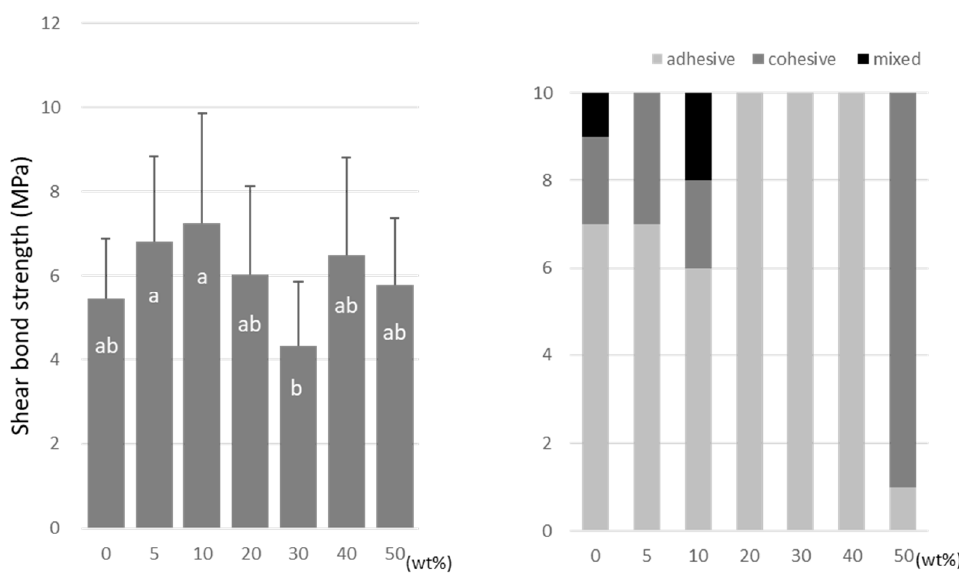
Figure 6. Shear bond strength ( left ) between CAD/CAM PMMA disk and TMPTMA. Same letters (a,b) in each column are not significantly different ( p > 0.05). Distribution of failure modes after test ( right ).